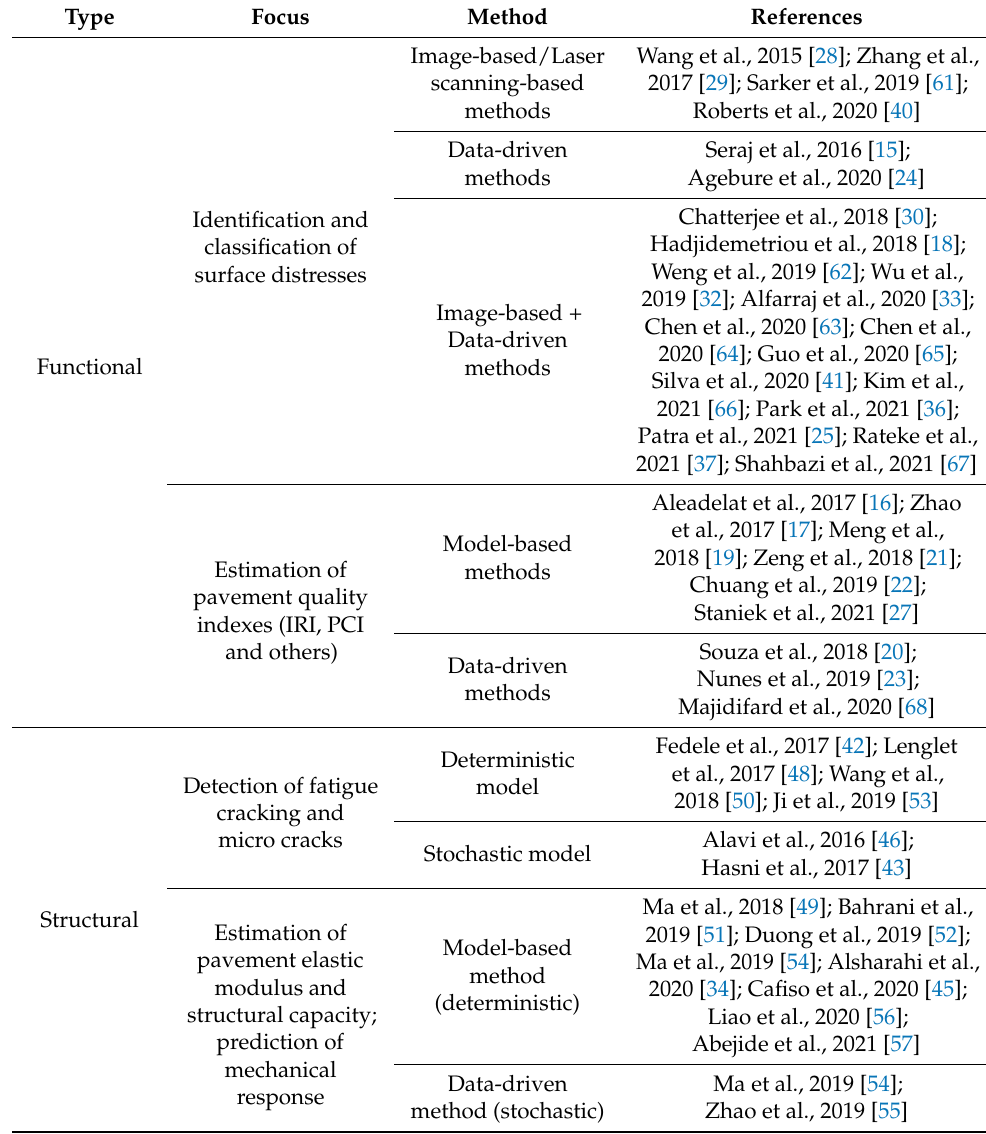
Table 3. Classification of research developments by data analysis